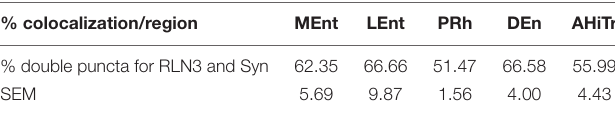
Two single optical sections per case for each structure were taken at 40 × magnification and between 2–3 microns from the section surface. Then, double- labeled and single-labeled putative RLN3 terminals were counted and averaged for a single case. The standard error of the mean (SEM) was obtained